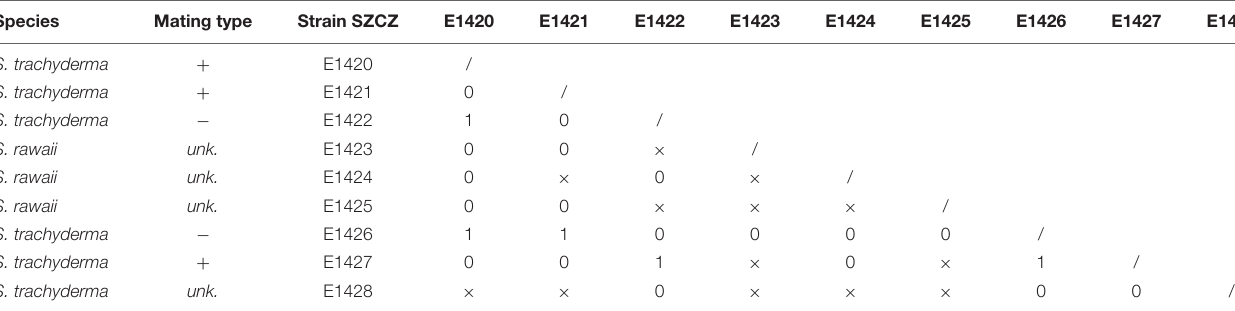
TABLE 2 | Results of mating experiments of Schizostauron spp.